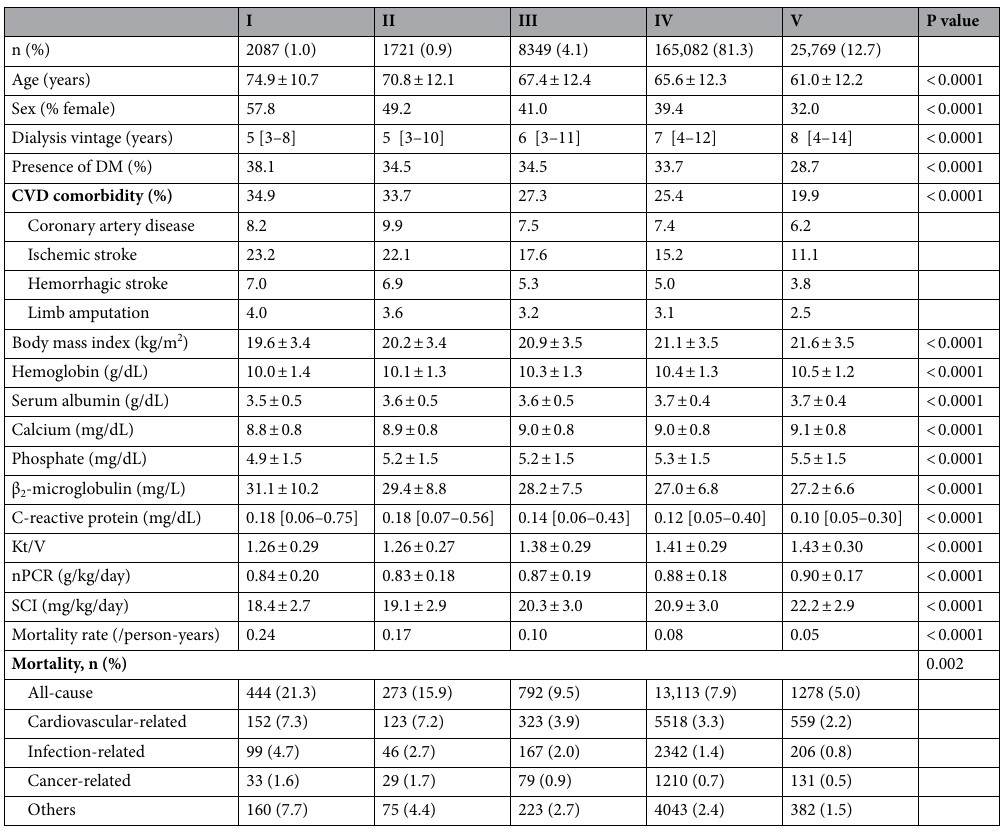
Table 3. Clinicodemographic and laboratory values in 203,008 hemodialysis patients according to dialyzer type. CVD cardiovascular disease, DM diabetes mellitus, nPCR normalized protein catabolic rate, SCI simplified creatinine